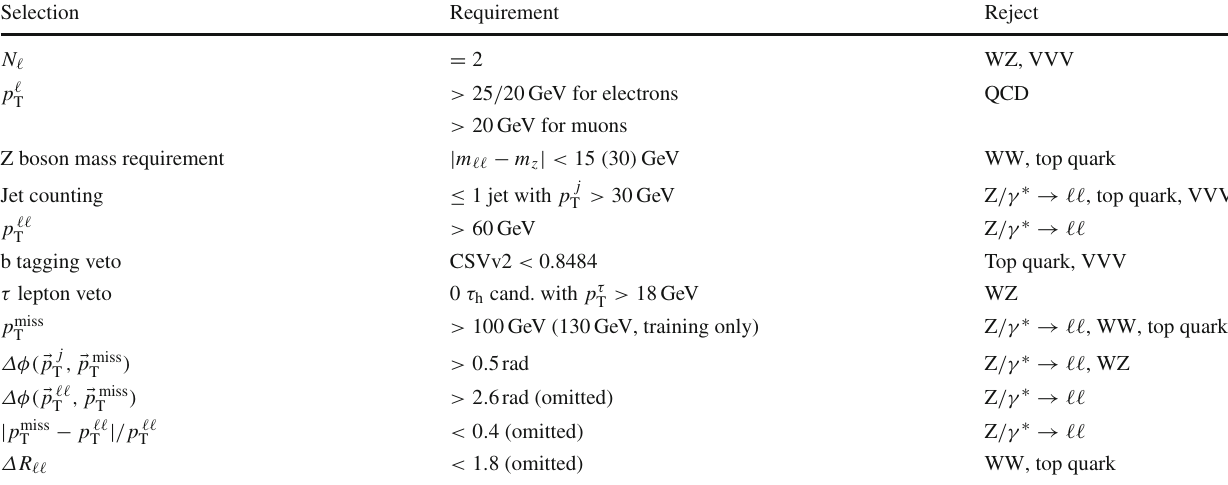
Table 1 Summary of the kinematic selections for the signal region of both the the p miss for the two analyses differ, the BDT requirement is given in parentheses Selection